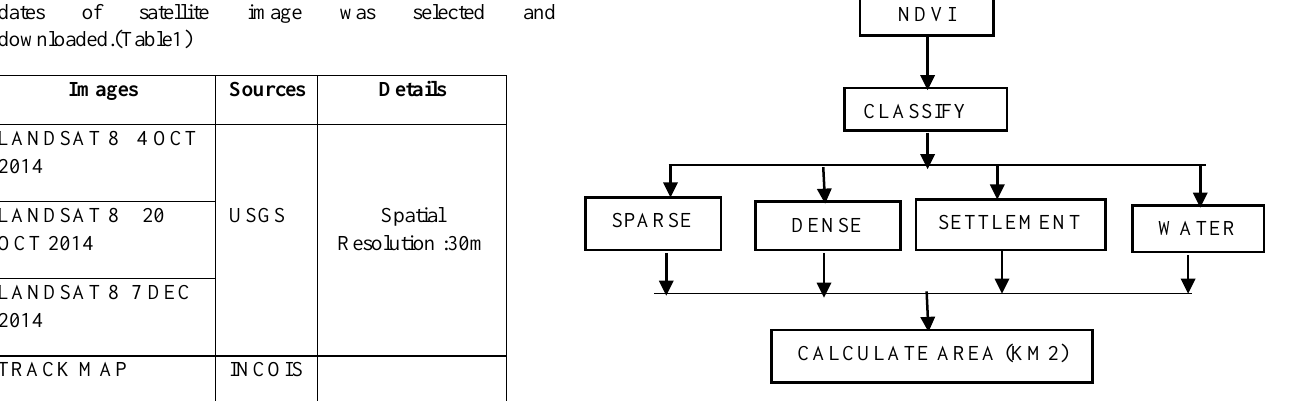
Table 1. Details of the Data used in this Study